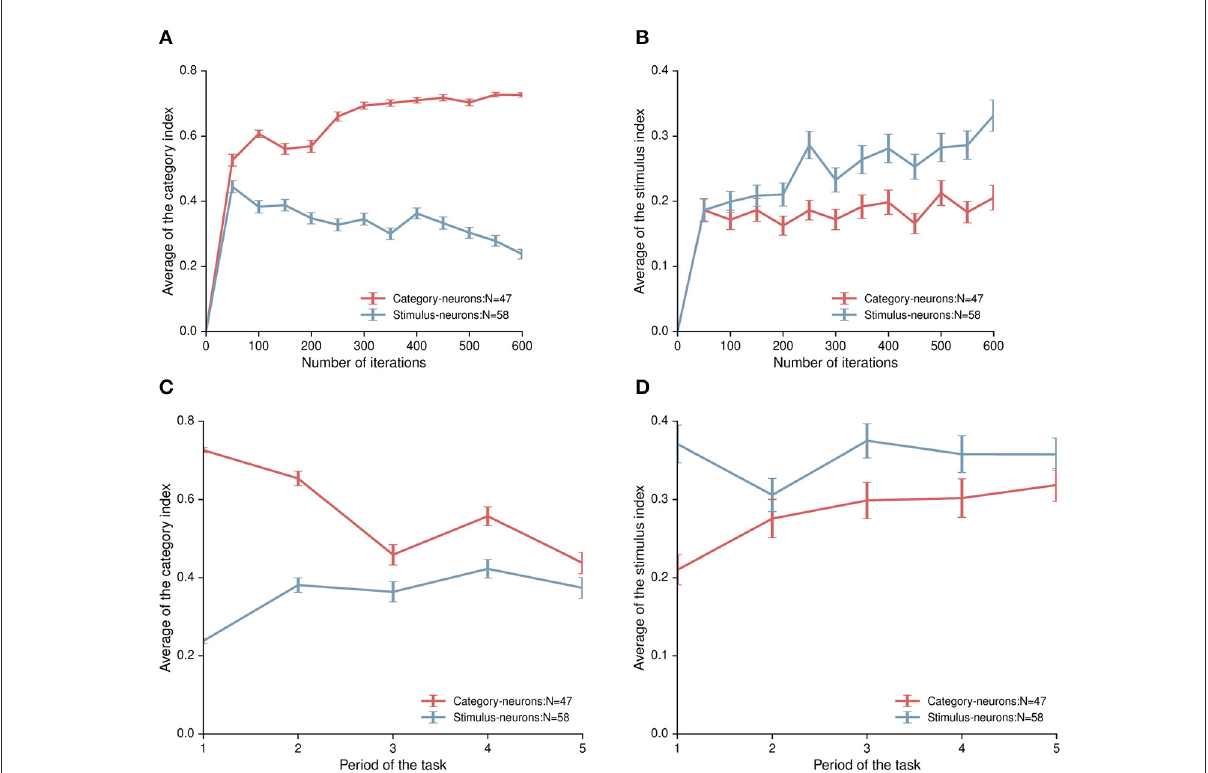
FIGURE6 The category index and the stimulus index of category-neurons and stimulus-neurons. (A) The time course of the category index for category-neurons (the red curve) and stimulus-neurons (the blue curve) during the network model learning the task. (B) The time course of the stimulus index for category-neurons (the red curve) and stimulus-neurons (the blue curve) during the network learning the task. (C) The category indexes for category-neurons (the red curve) and stimulus-neurons (the blue curve) in five different task periods after the model learned the task. (D) The stimulus indexes for category-neurons (the red curve) and stimulus-neurons (the blue curve) in five different task periods. The number “1,” “2,” “3,” “4,” and “5” in the horizontal coordinates indicate the first stimulus period, the first delay period, the second stimulus period, the second delay period, and the third stimulus period,